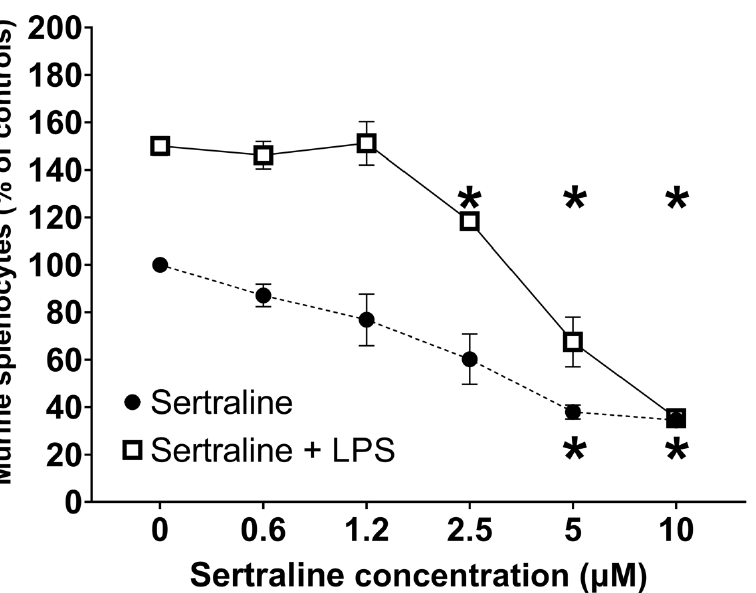
Figure 2. Effect of sertraline on viability of murine splenocytes—Viability was measured under basal conditions and following exposure to LPS (0.1 µg/well). Points represent mean ± SE of three separate experiments, expressed as percentage of control. Proliferation was assessed by Alamar Blue following 48 h incubation. RM-ANOVA revealed p < 0.001. * p < 0.05 vs. basal.